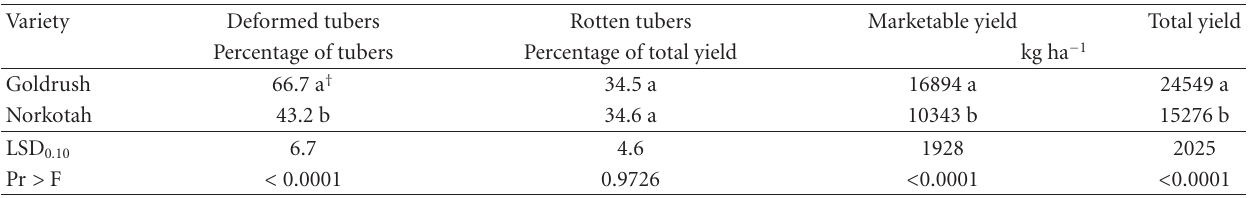
Table 3: Russet potato main e ff ect in 2009 for deformed tubers, rotten tubers as a percentage of total yield, marketable tuber yield, and total tuber yield for Russet potatoes grown on sandy loam soils in the Mid-Atlantic, averaged across N rate and N application timing.